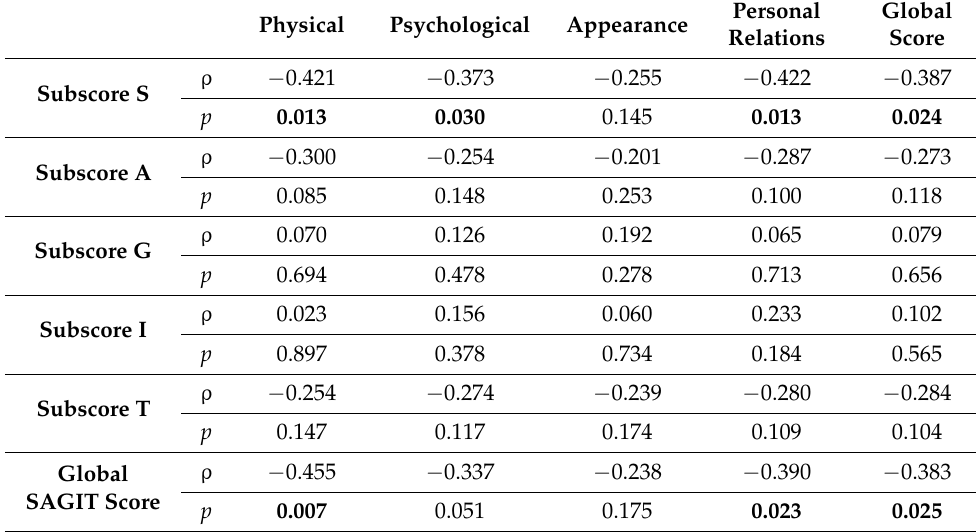
Table 3. Correlations between SAGIT and AcroQoL scores at follow